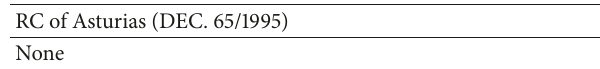
Table 5: Species included in the regional catalogue (RC) of Asturias (DEC. 65/1995).